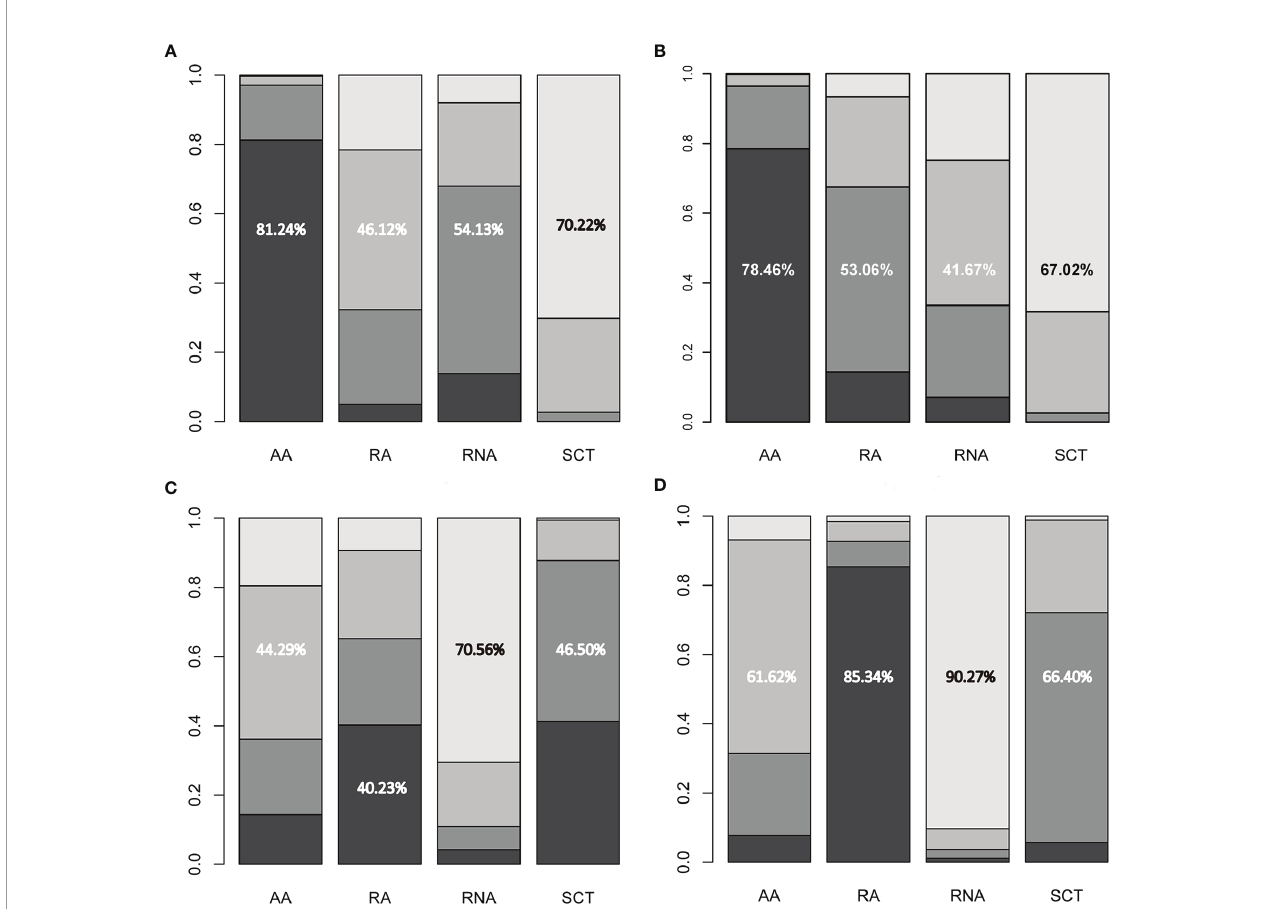
FIGURE 4 | Ranking probabilities of available regimes for (A) disease-free survival, (B) overall survival, (C) any adverse events, and (D) grade 3 – 4 adverse events. The numerical values indicate the probability of ranking at certain places. AA, addition of capecitabine to adjuvant chemotherapy; RA, replacement of capecitabine to adjuvant chemotherapy; RNA, replacement of capecitabine to neoadjuvant chemotherapy; SCT, standard